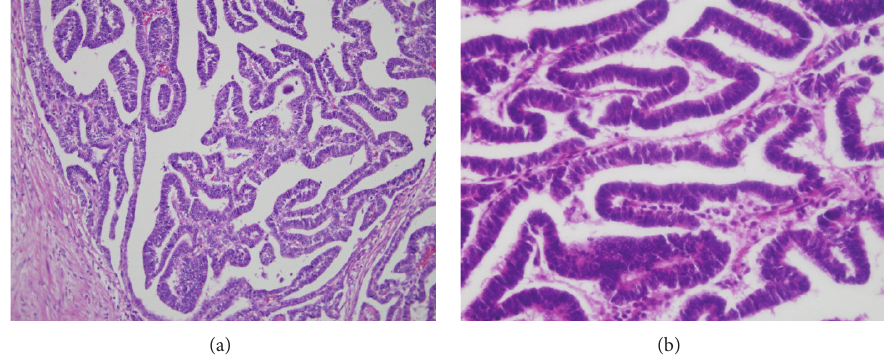
Figure 2: Microscopic findings of the tumor. (a) The tumors were composed of papillotubular architectures with an invasive growth. The stroma showed hyalinization. (b) The tumor cells were high columnar epithelia. The nuclei were oval in shape with fine chromatin and inconspicuous nucleoli. The cytoplasm was